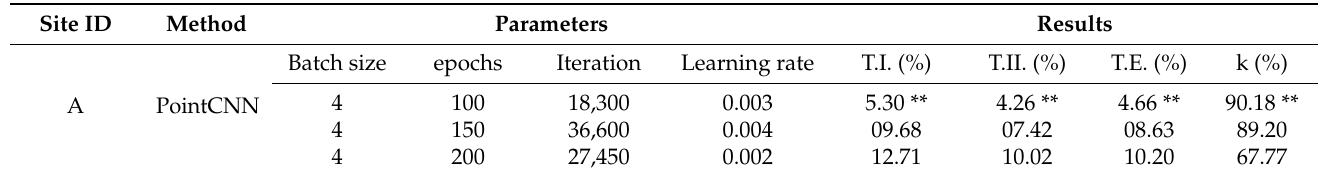
Table 6. PointCNN ground classification error metrics and kappa